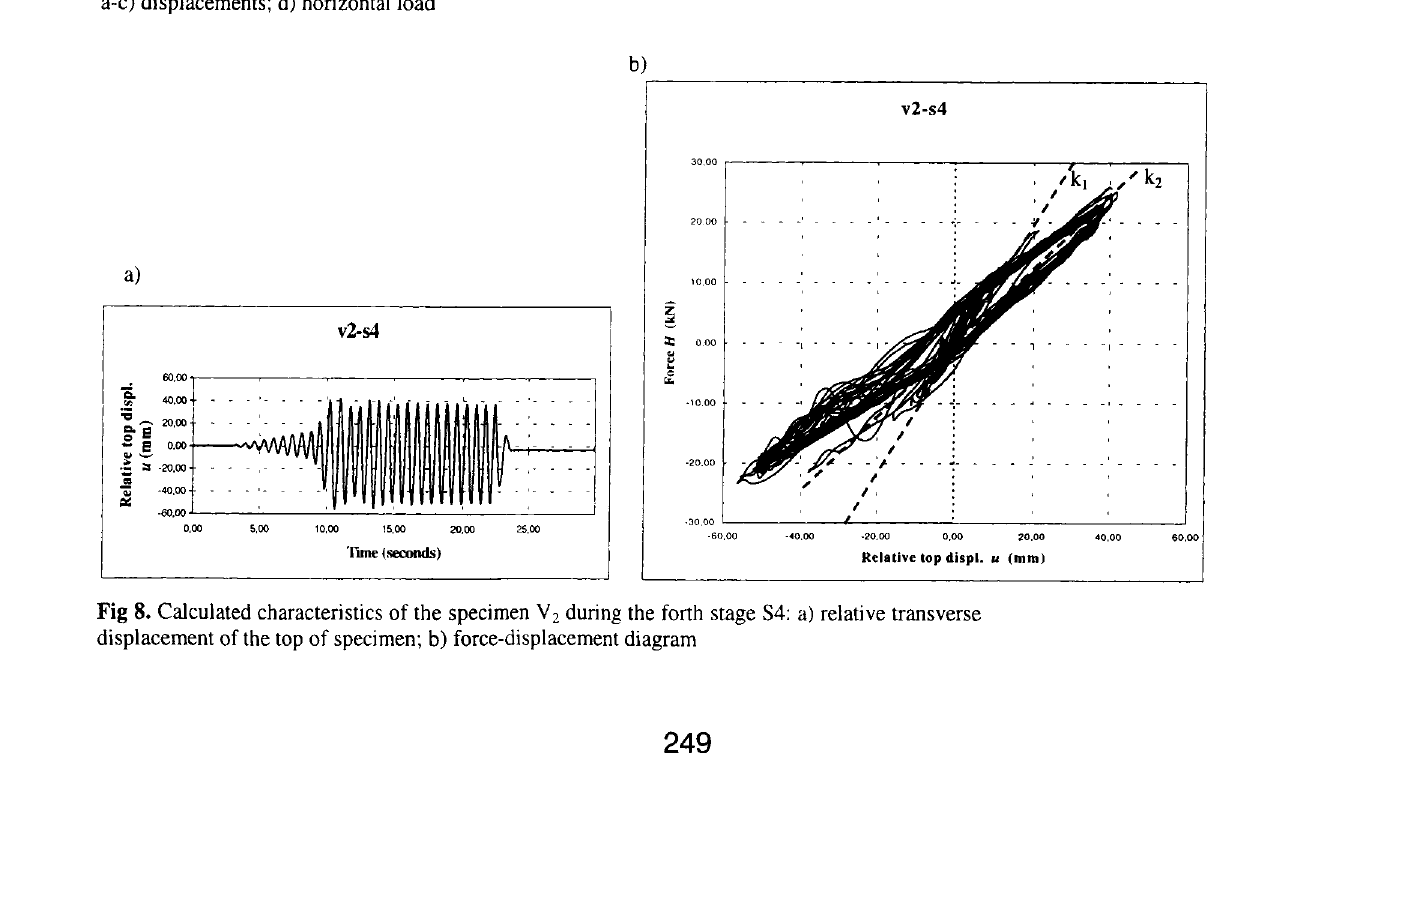
Fig 7. Selected characteristics of the specimen V 2 measured during the forth stage S4 of the experiment: a-c) displacements; d) horizontal load